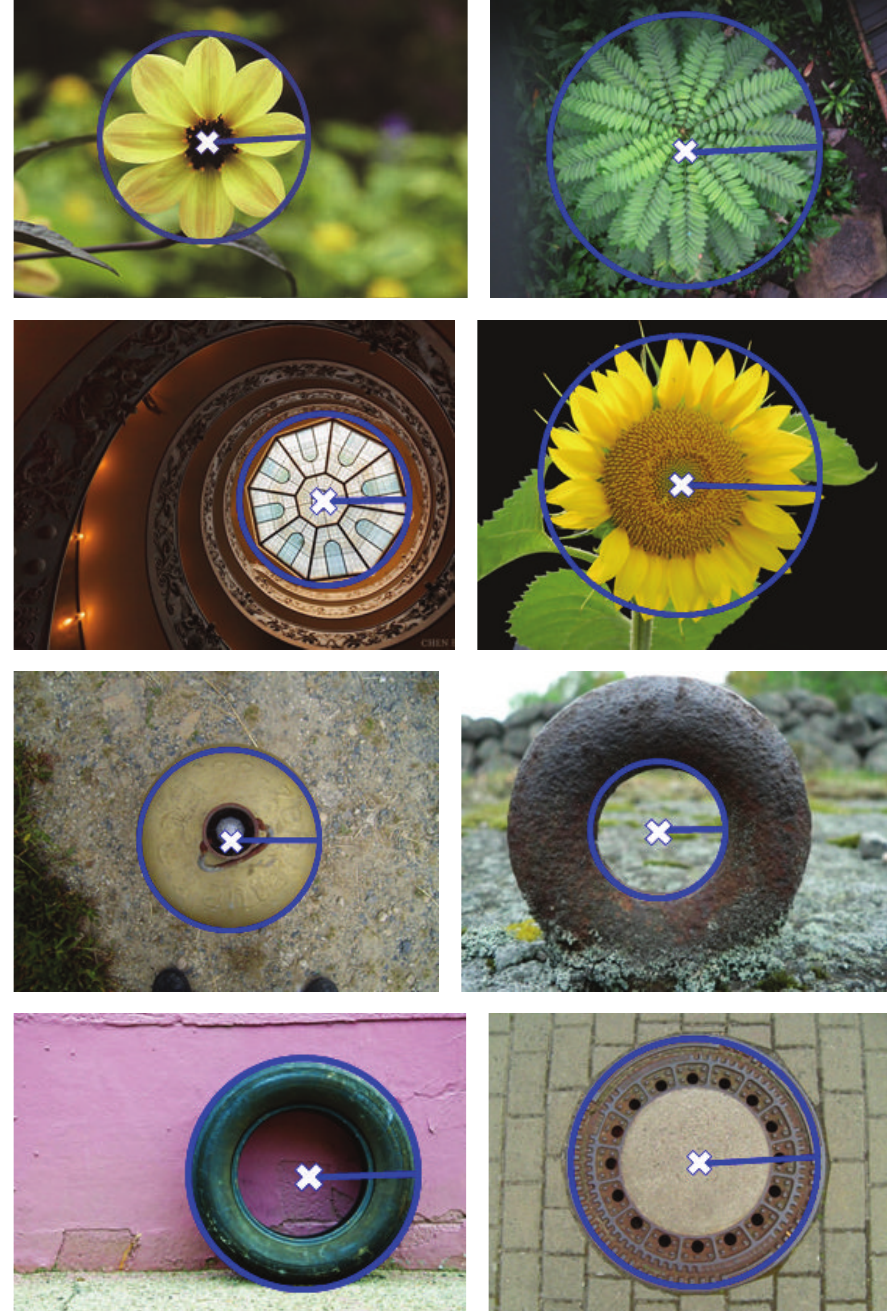
Figure 5: Results of images with aligned rotational